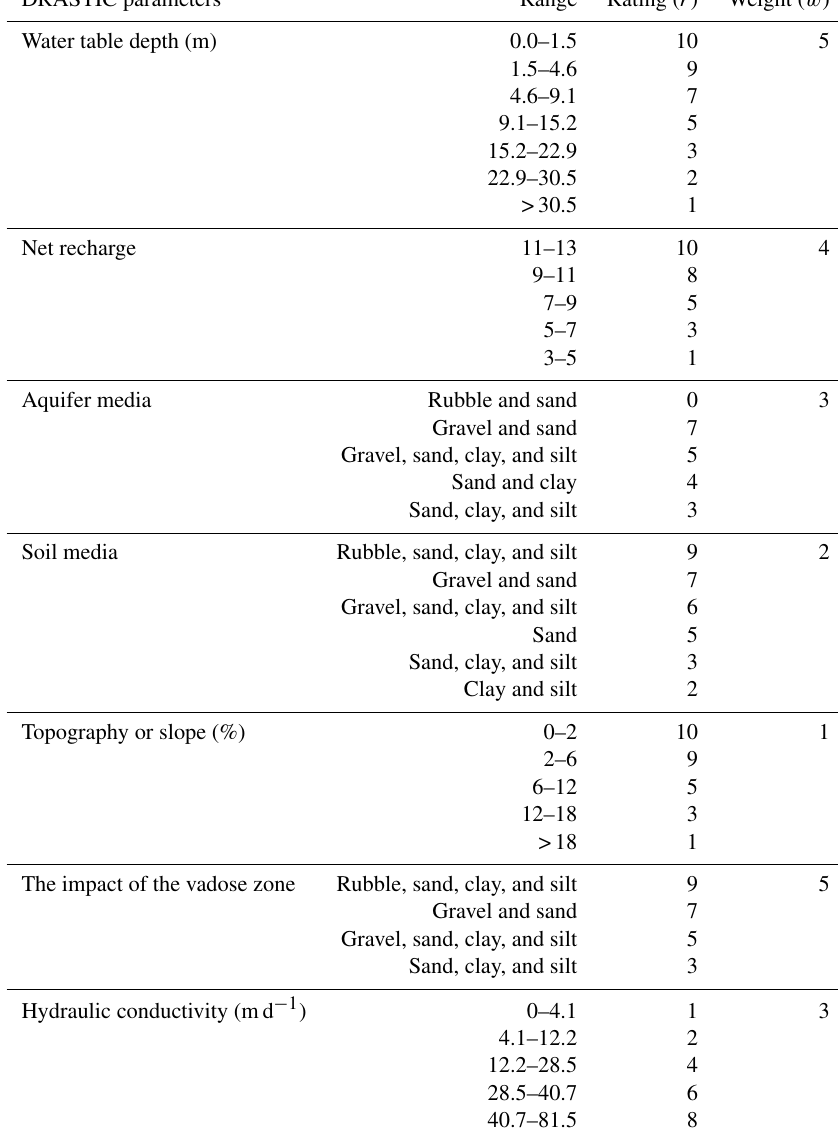
Table 1. Ratings and weights related to DRASTIC index factors (Aller et al., 1985). DRASTIC parameters